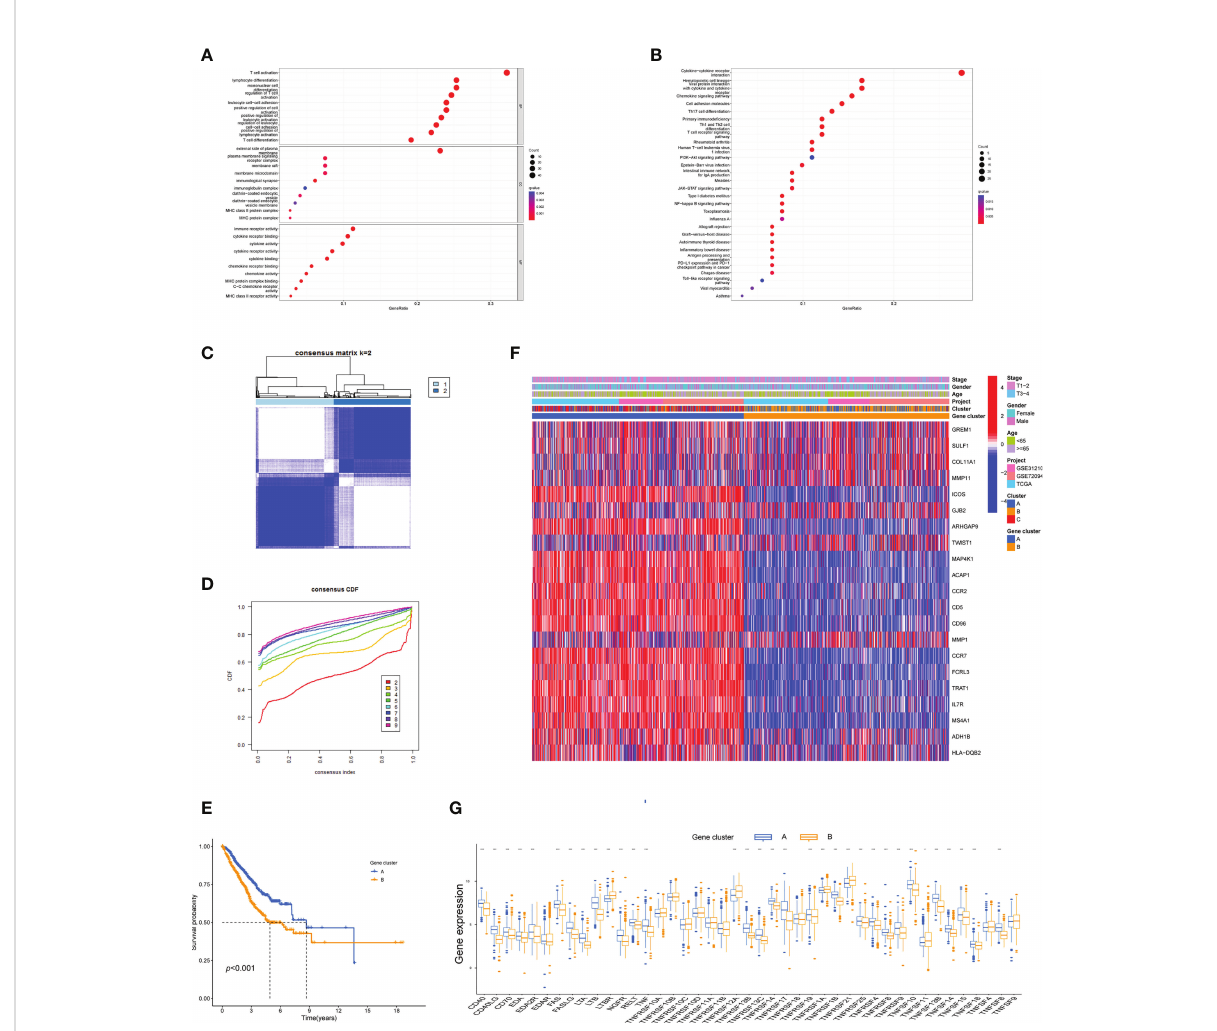
FIGURE 3 Identi fi cation of the TNF gene clusters based on the DEGs. (A, B) GO and KEGG enrichment among the three clusters. (C) Consensus matrix heatmap de fi ning the two gene clusters (k = 2) and their correlation area. (D) Cumulative distribution function (CDF) when k = 2 – 9. (E) Kaplan – Meier curves for the two gene clusters (log-rank tests, p < 0.001). (F) Heatmap shows the relationships between the clinicopathological characteristics of the patients and the two distinct gene clusters. (G) Boxplot shows the expression distributions in 43 TNFRGs among the two gene clusters; *p < 0.05, ***p <